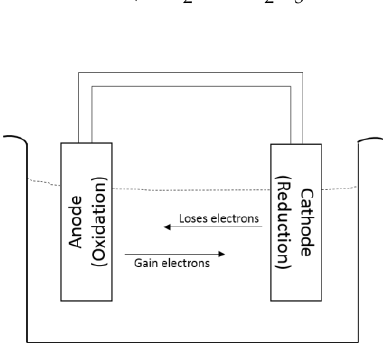
Figure 1: Electrochemical cell [27]. Figure 1. Electrochemical cell